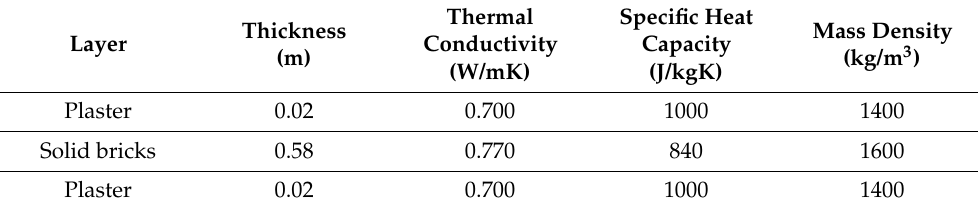
Table 2. Wall stratigraphy used in